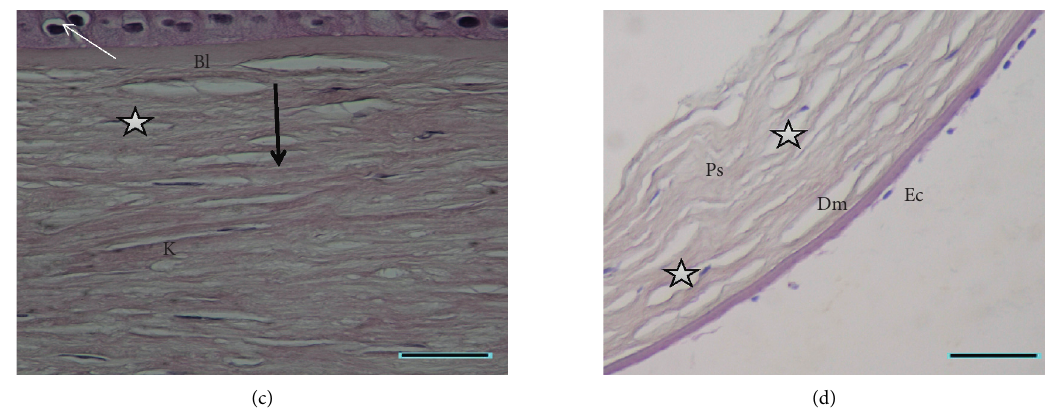
Figure 5: Corneal sections of Schnyder dystrophy stained with hematoxylin and eosin showing changes in the basal epithelial cell layer and stromal vacuolization and decreased keratocyte density. (a-b) the epithelium is formed by 4 to 7 layers. Columnar basal cells (Bc) feature apical nuclei surrounded by a clear halo and mild cytoplasmic vacuolization (thin arrows). Locally, the corneal epithelium can be detached (stars) from Bowman layer (Bl). Empty interlamellar vacuoles (arrows) are observed in the anterior and mid-stroma. The Bowman layer is preserved. (c) Mild cytoplasmic vacuolization (thin arrow) in the basal epithelial cells with preserved the Bowman layer. Some keratocyte nuclei K, as well as empty vacuoles (star), are noted in the anterior stroma. However keratocyte density is decreased from the anterior down to the posterior corneal stroma. (d) The posterior stroma (Ps) shows interlamellar vacuoles (stars). Descemet membrane (Dm) and endothelial cells appear to be normal. Scale bar show 20 μ m.